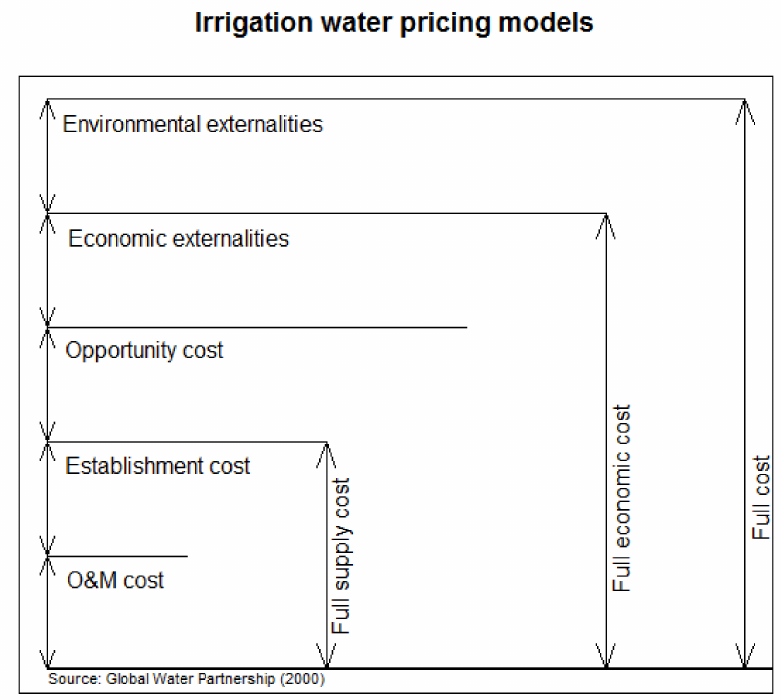
Figure 1. Irrigation pricing models defined by the Global Water Partnership